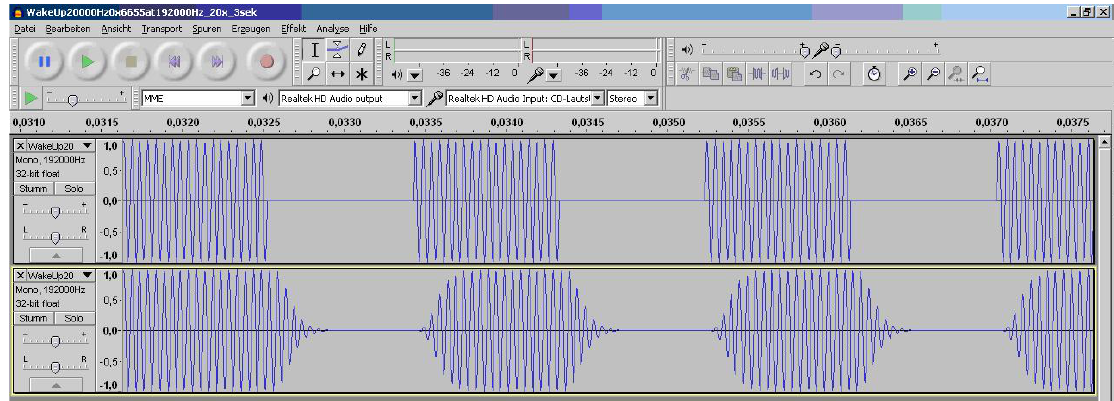
Figure 6. The upper part represents a section of an unoptimized acoustic wake-up signal. By applying a bandpass filter, an optimized acoustic wake-up signal will be generated similar to the lower part.